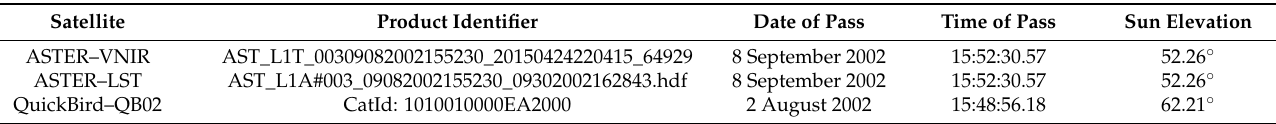
Table 1. Details of satellite data product used in this